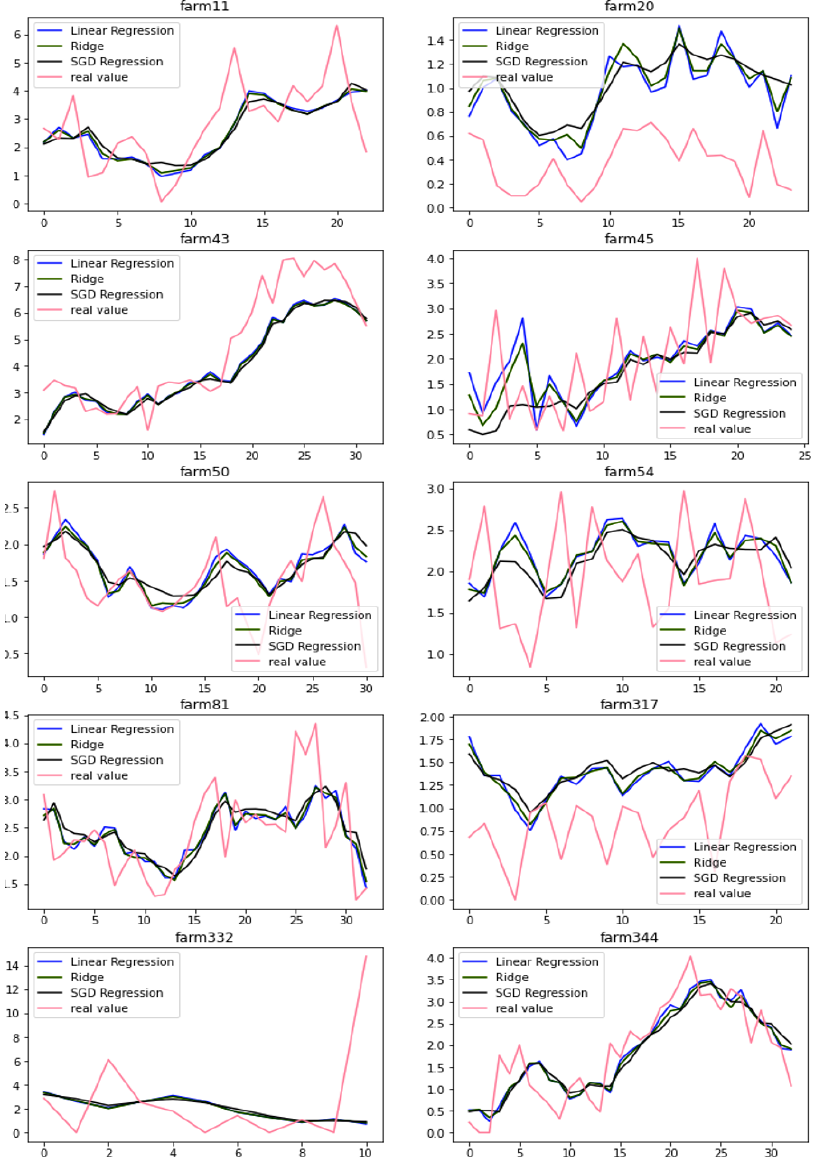
Figure 6. Scatterplot between predicted values and actual values.